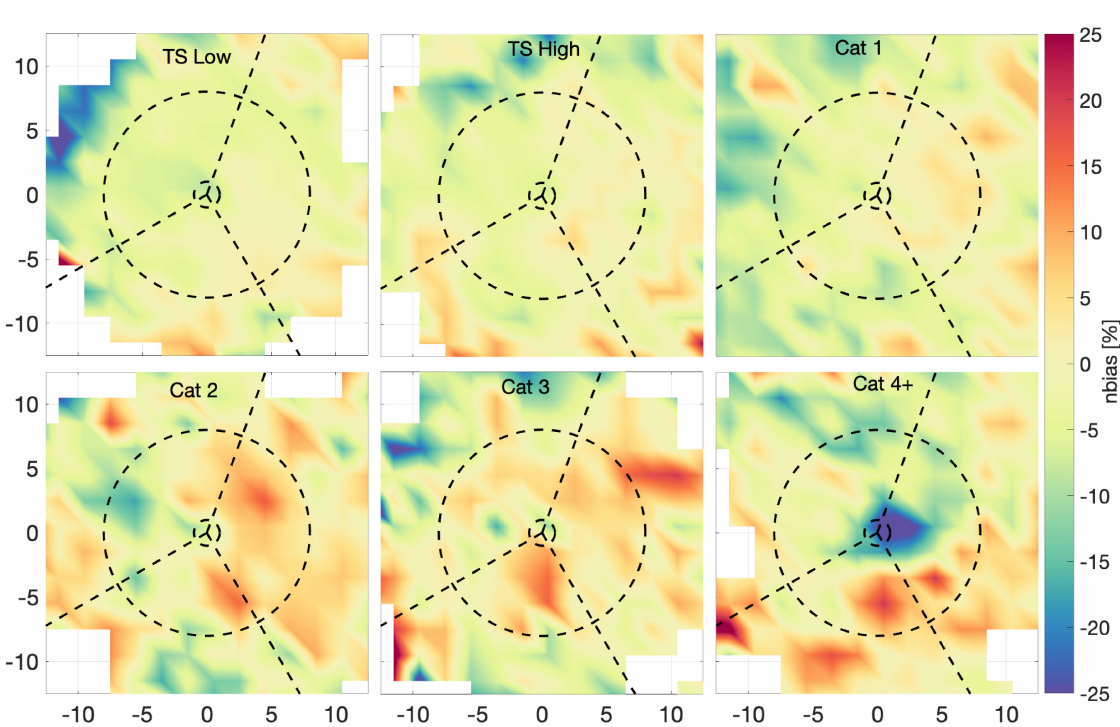
Figure 13. Each subplot as in Figure 12a for each category of the S-S intensity scale. (Note the difference in color scale). Comparing subplots outside of R = 8, there is less consistency in relative bias across intensity, with overestimation found in the forward right of Cat 1 storms, and underestima- tion found in the left of the back section for Cat